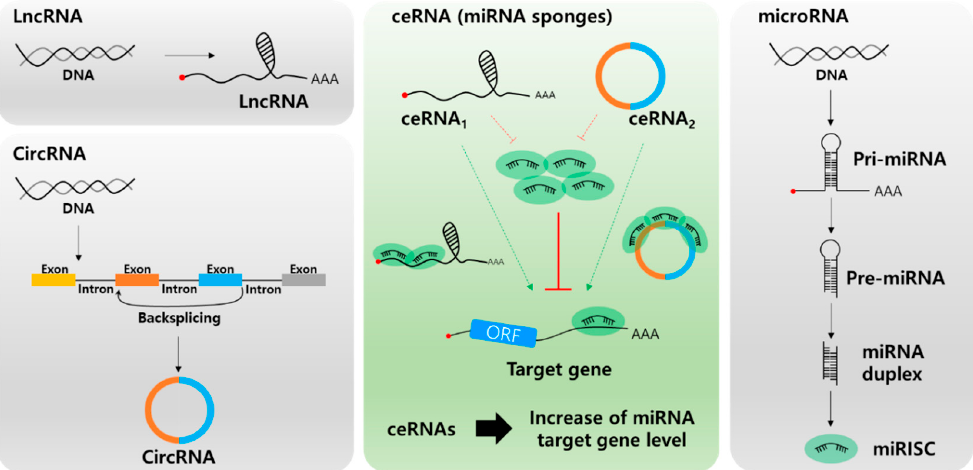
Figure 2. Biogenesis of long non-coding RNA (lncRNA, top left), circular RNA (circRNA, bottom left), microRNA (miRNA, right), and the role of lnc/circRNA as competing endogenous RNAs (ceRNAs, center). Different types of ceRNAs including lncRNA and circRNA regulate the miRNA target mRNA expression by competing for miRNA binding.